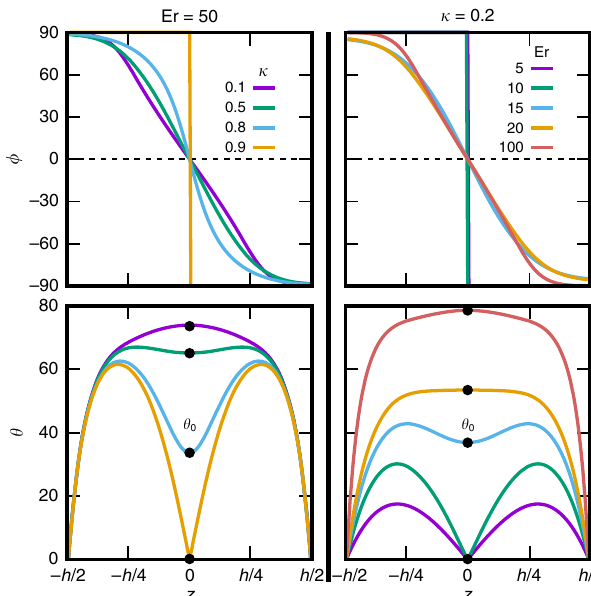
Fig. 5 Vertical director pro fi le variation with fl ow rate and elastic anisotropy. Twist angle ϕ and tilt angle θ , revealed by numerical integration of Eq. (8) (see Methods) for varying elastic anisotropy. κ (left column) and Ericksen numberEr(right column). At small elastic anisotropies, director structure is in the achiral B state, characterised by a sharp transition from ϕ ¼ 90 (cid:7) to ϕ ¼ (cid:1) 90 (cid:7) and large director tilt in the fl ow direction in the upper and bottom half of the channel. As κ is reduced, θ 0 in the middle of the channel becomes non-zero and ϕ pro fi le smooths out, indicating a chiral transition from the director tilt in the bottom and in the upper half, characteristic for the B (cid:3) con fi guration, as already discussed in Fig. 4. Similarly, director is in the B state for small values of Er. The director tilt angle increases with increasing Er, until a transition to B (cid:3) state is